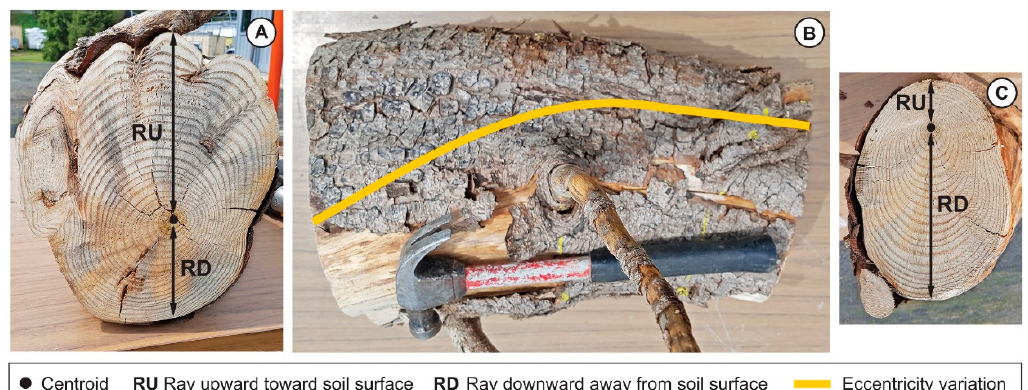
Figure 6. Variation in annual ring eccentricity in the shallow root within the cage. Panel A shows the cross-sectional area (CSA) at the branching point ( A ). Panel B shows the tapering of the lateral root axis from the branching point to the cage edge ( B ). The yellow line connects the two centroids of the CSA. Panel C shows the annual ring eccentricity at the cage edge ( C ).